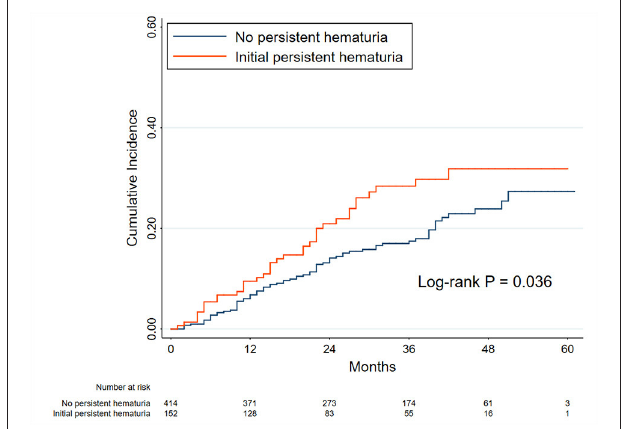
FIGURE 2 | Kaplan-Meier curves for relapse in patients with and without initial persistent hematuria. The initial hematuria was defined as the average hematuria of the first 6 months of follow-up in patients with primary membranous nephropathy. The initial persistent hematuria was defined as an initial hematuria > 5 RBCs/HPF. Between-group comparison was performed using the log-rank test. The time zero was when a person first attained partial remission.